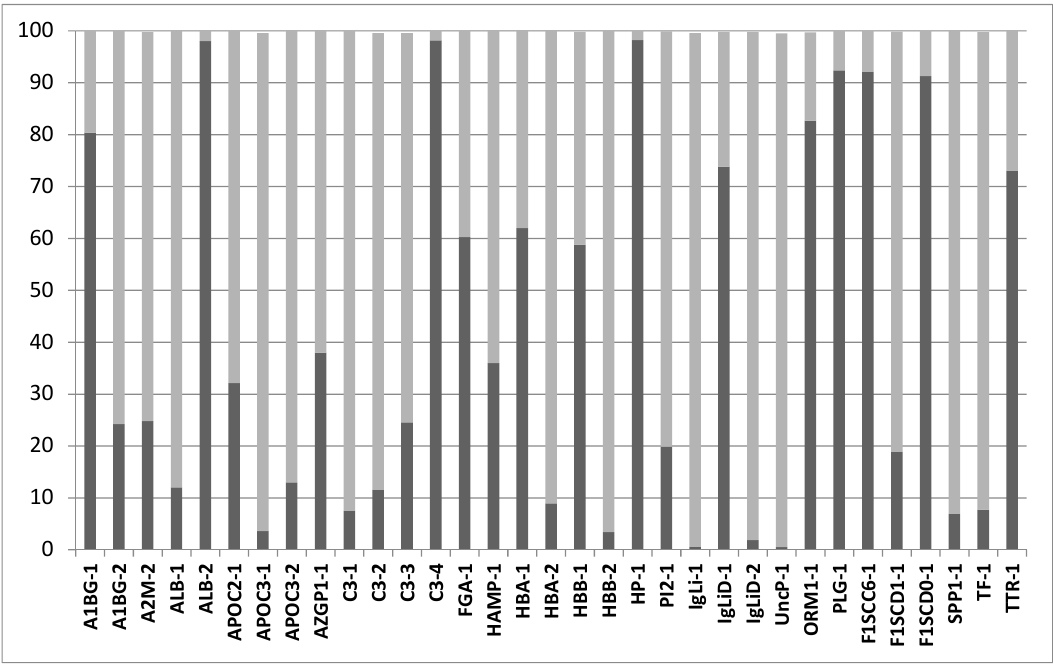
Figure 4. Relative percentage of forms deriving from endopeptidase (light gray) or endopeptidase followed by exopeptidase (dark gray) forms of the peptides undergoing endo- and exopeptidase cleavages listed in Table S2.